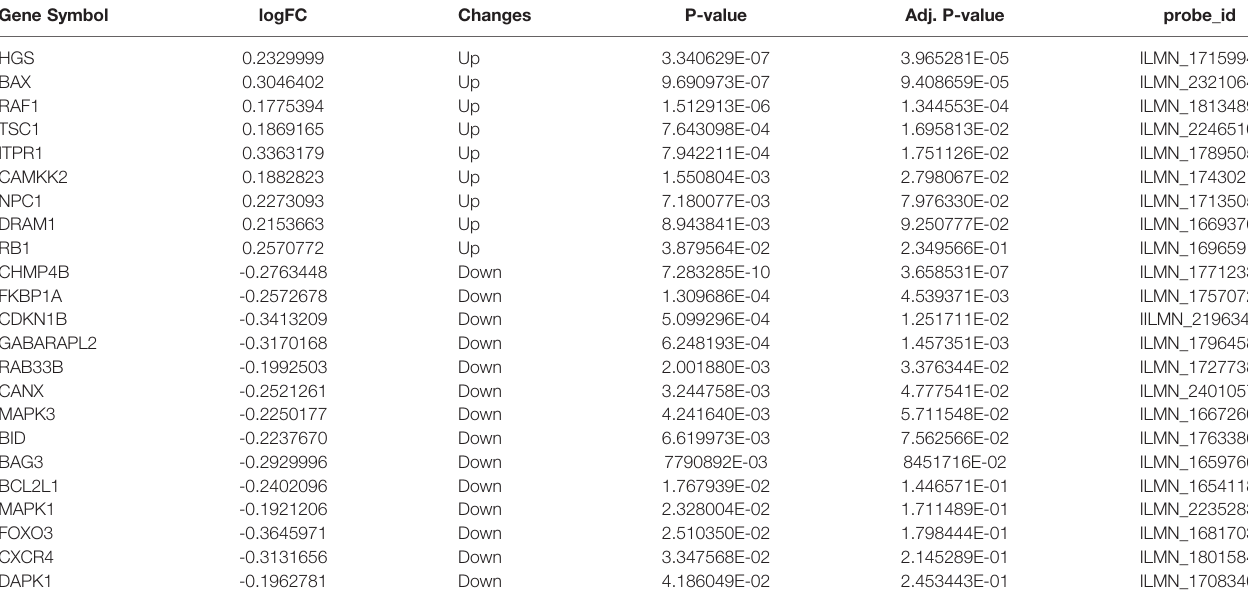
TABLE 1 | The 23 differentially expressed autophagy-related genes in DR samples compared to healthy samples. Gene Symbol logFC Changes P-value Adj.